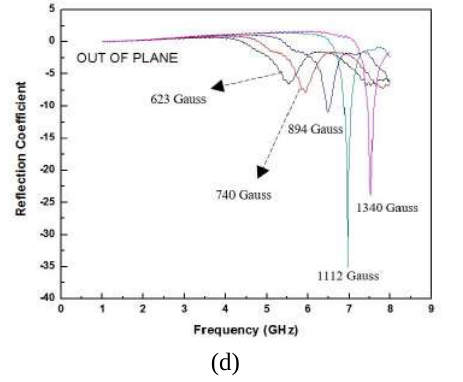
Figure 3: Ferromagnetic Resonance (FMR) measurements using shorted coaxial probe method on ferrite materials a) YIG Single Crystal film (thickness 4 µm) b) YIG Single Crystal film (thickness 24 µm) c) YIG Single Crystal film (thickness 124 µm) d) NFO Polycrystalline sample (thickness 0.2